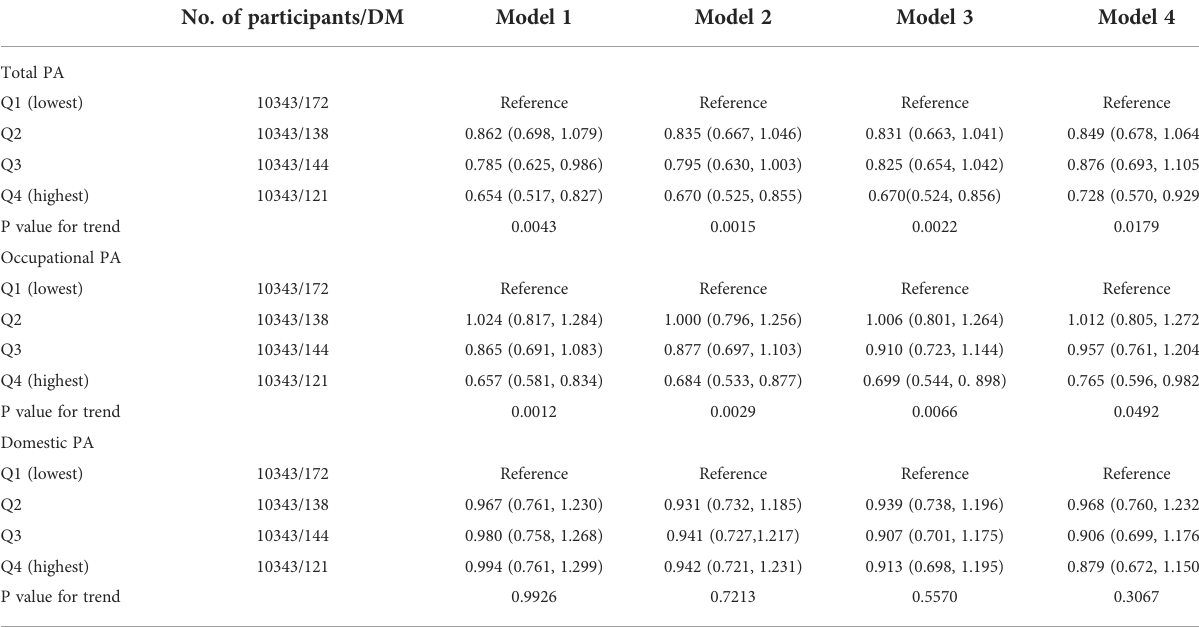
TABLE 2 HRs (95% CI) of diabetes according to the quartiles of total PA, occupational PA, and domestic PA.